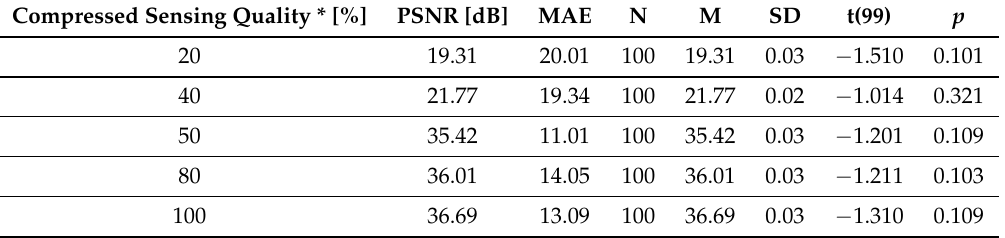
Table 8. The performance of the presented algorithm for the data from the Figure 8 at different Compressed Sensing quality